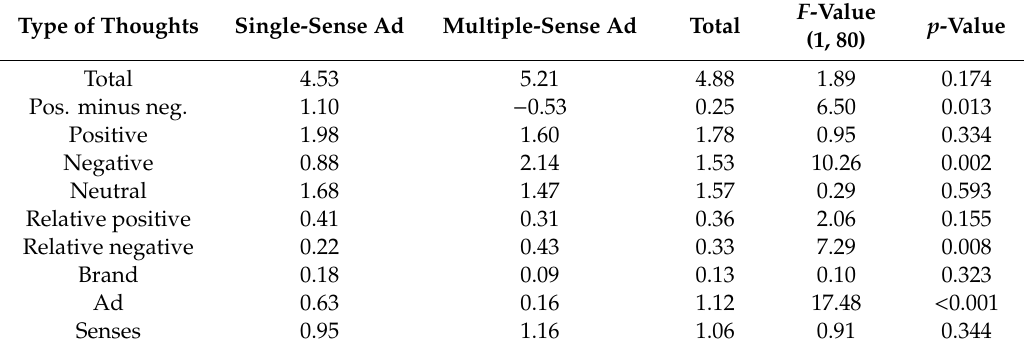
Table 1. Results of Study 2. Mean number of thoughts elicited by the single-sense versus multiple- sense ad.